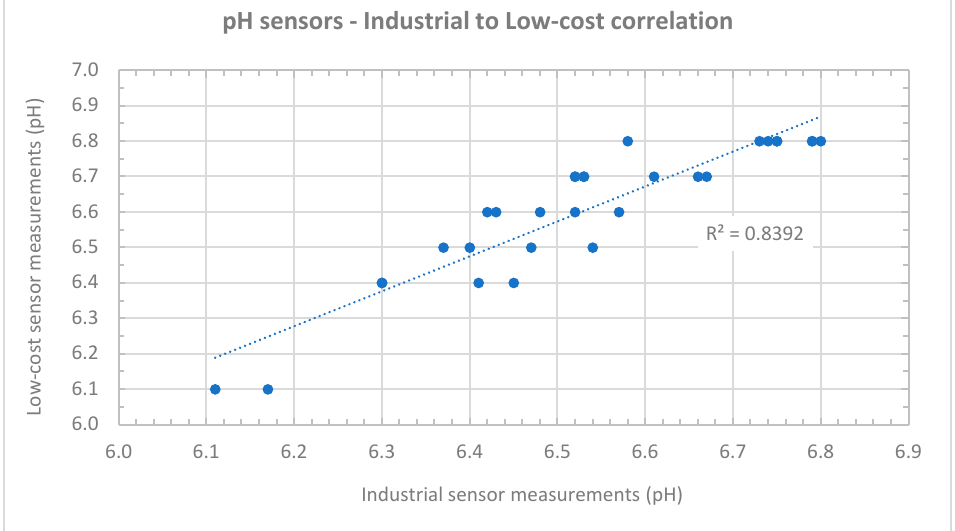
Figure 4. Correlation of industrial and low ‐ cost pH sensors’ measurements.